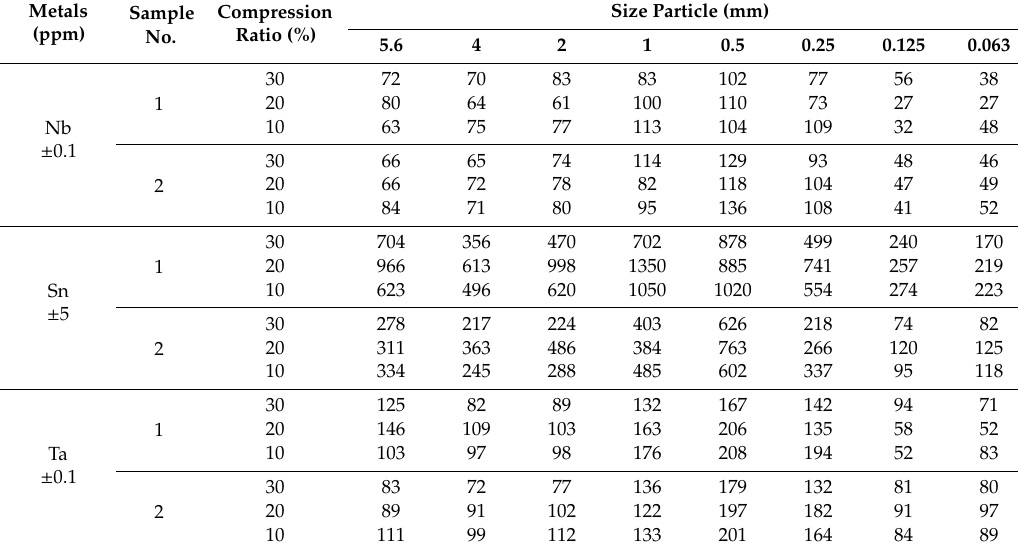
Table 3. Niobium (Nb), tin (Sn) and tantalum (Ta) content in di ff erent size fractions of the Penouta ore after compression breakage at compression ratios of 30%, 20% and 10% for samples 1 and